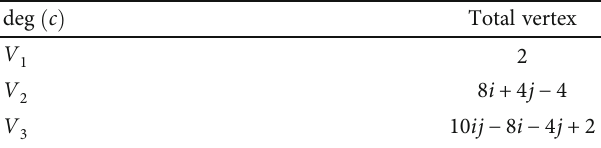
- II ½ i, j (cid:2) 4